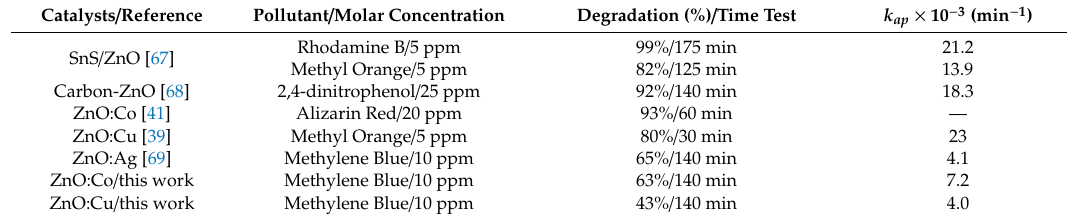
Table 3. k app values for di ff erent catalysts (ZnO doped with di ff erent metals) under visible irradiation. Catalysts /